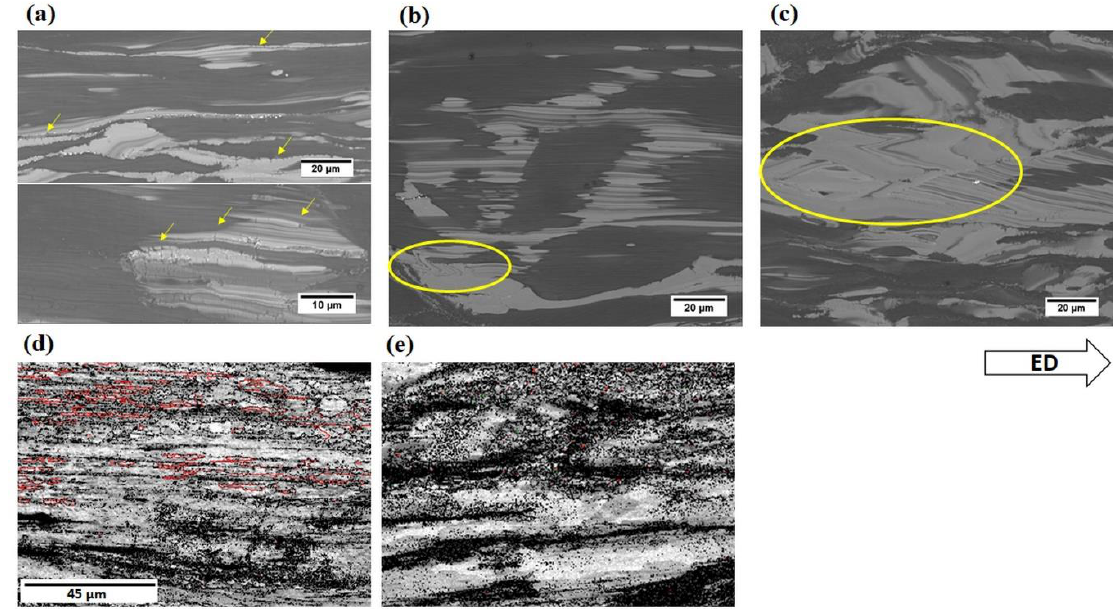
Figure 3. The microstructures of ( a , d ) WZ42, ( b , e ) WZ72, and ( c ) WZ104 alloys after full-cycle deformation. Kinking and cracks are highlighted by yellow marks in backscatter electron (BSE) images ( a – c ). Boundaries of tensile twins are marked in red color in image quality (IQ) maps in ( d , e ).